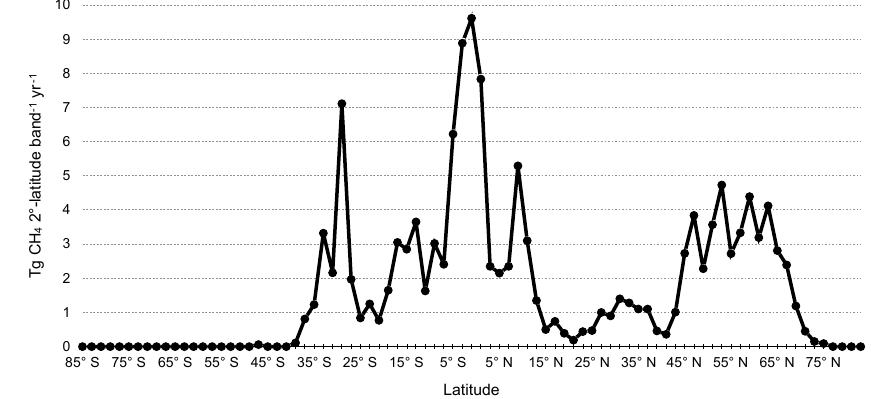
Figure 2. Annual zonally summed wetland methane emissions (TgCH 4 2 ◦ -latitude band − 1 yr − 1 ) for the optimized inventory.